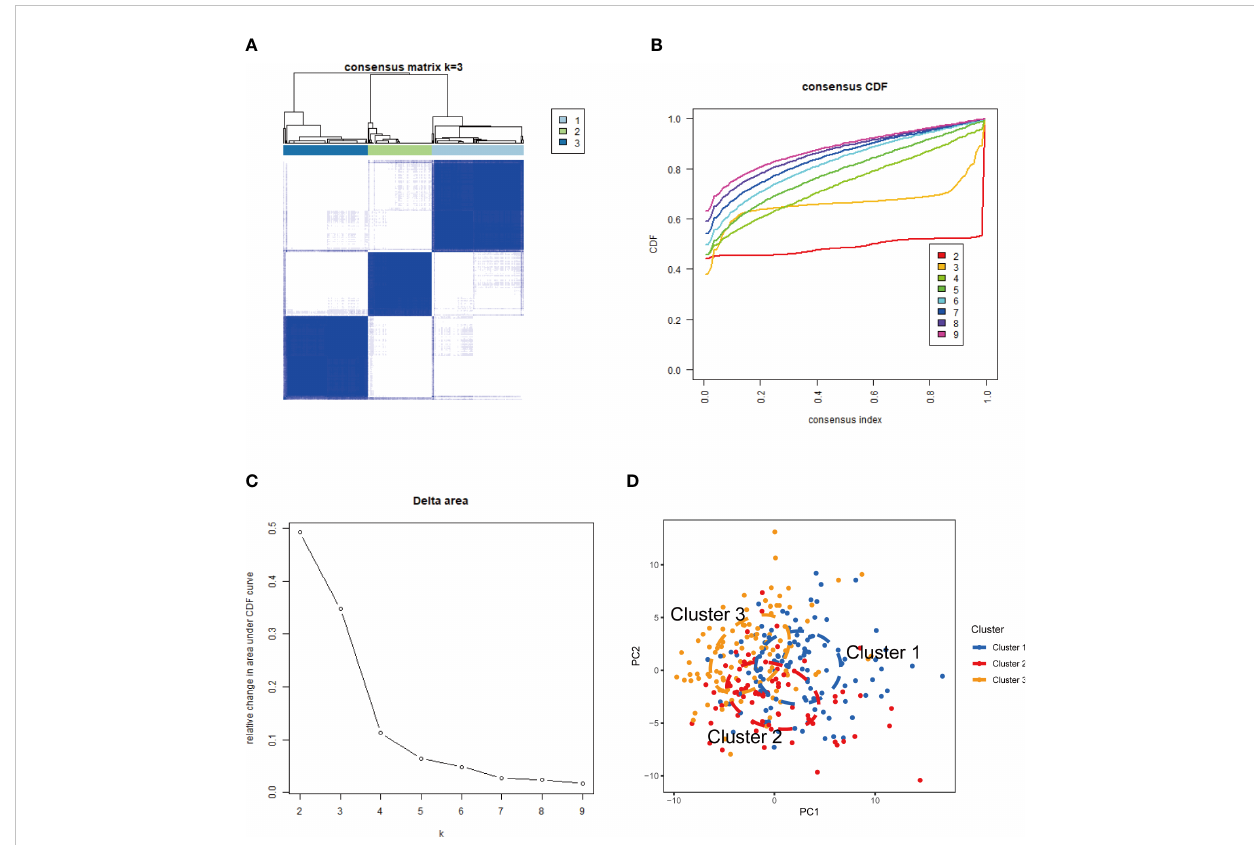
FIGURE 8 NETs-related molecular clusters identi fi cation in SLE. (A) Consensus clustering matrix when k = 3; (B) Consensus clustering CDF for k = 2 – 9. (C) Relative change in area under CDF curve for k = 2 – 9. (D) PCA was used to verify the three distinct subgroups divided by consensus clustering. SLE, systemic lupus erythematosus; CDF, cumulative distribution function; PCA, principal component